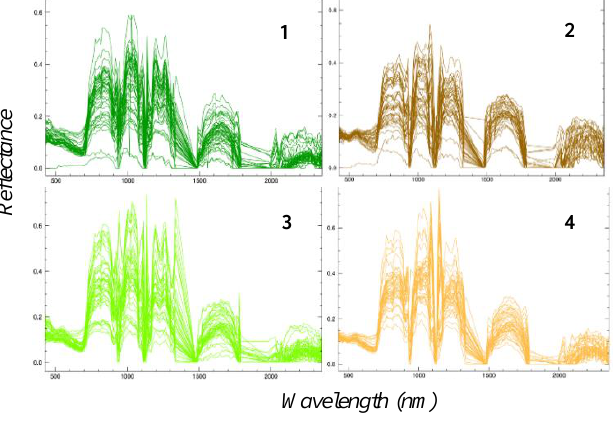
Figure 2. Results of PPI per land cover class showing the endmembers of (1) Closed forest, (2) Crop, (3) Open